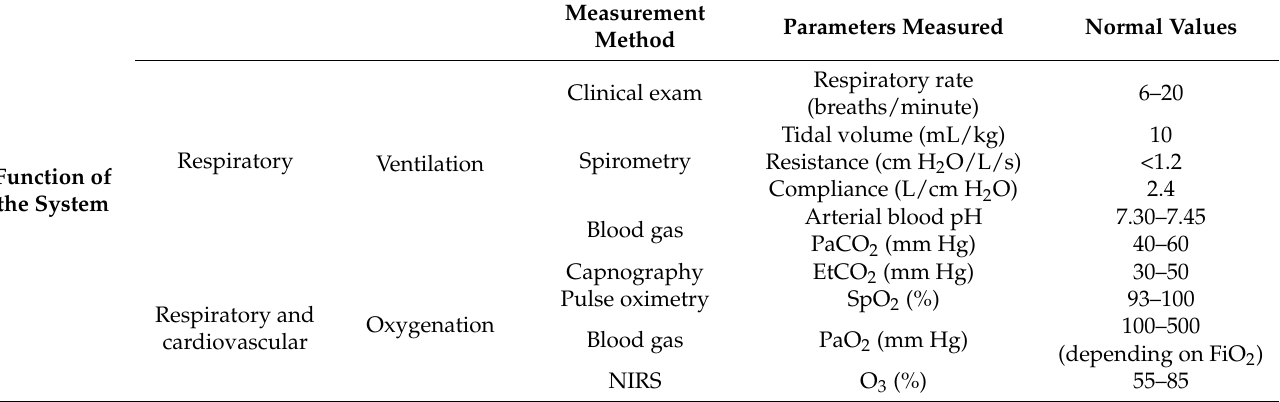
Table 1. Normal physiological values for anaesthetised horses (according to [44,51,58]).